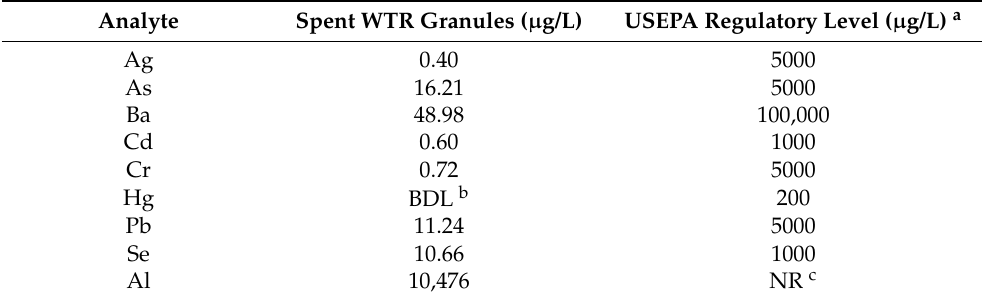
Table 4. Toxicity characteristic leaching values of metals and metalloids measured in spent WTR granules.